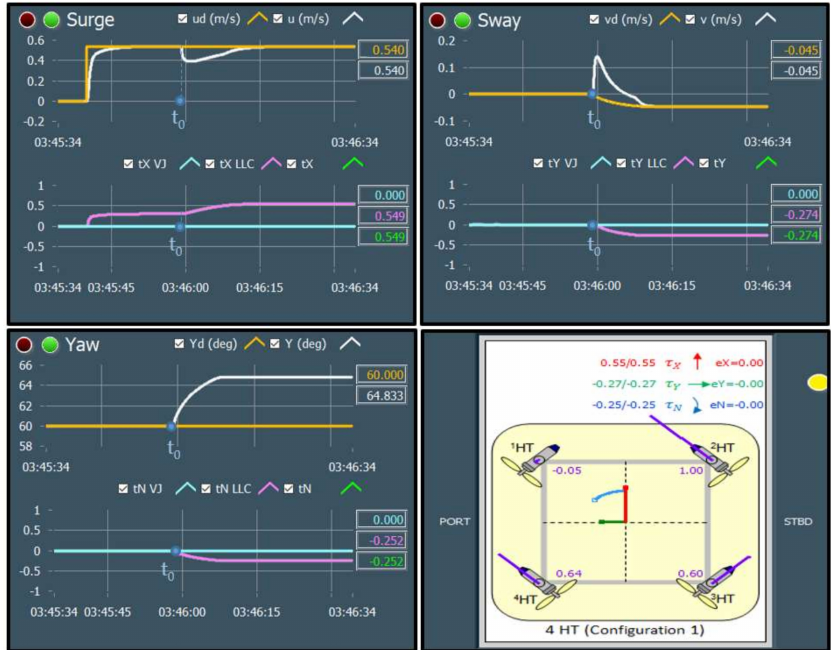
Figure 25. Test 2 (Closed-Loop): Total fault in HT2 (“Broken Propeller”) occurred at t 0 ; the lack of fault accommodation and robustness of the closed-loop controllers causes limited drift to the starboard side with a heading offset of 4.833 ◦ .